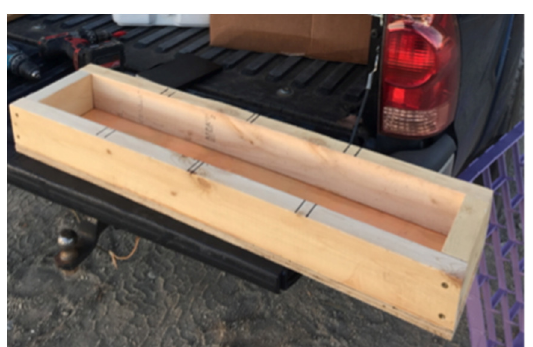
Fig. 4: Capstone Notes – Illustration of the mold structure